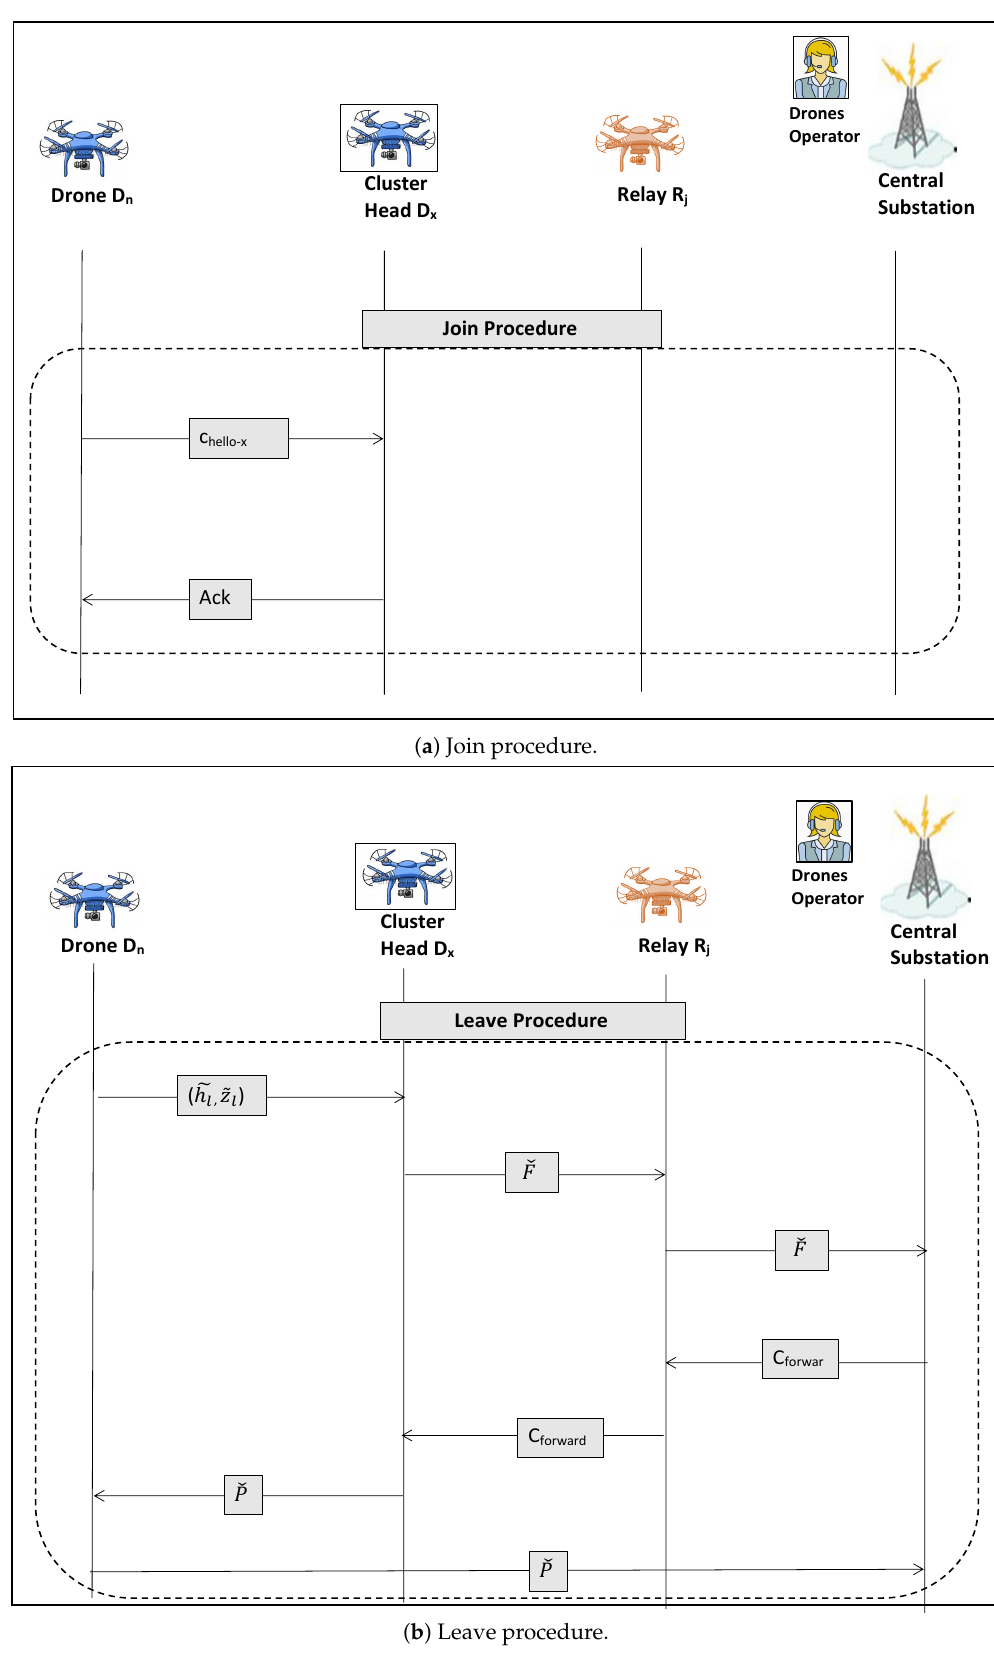
Figure 4. Surveillance UAV network operation phase—join/leave